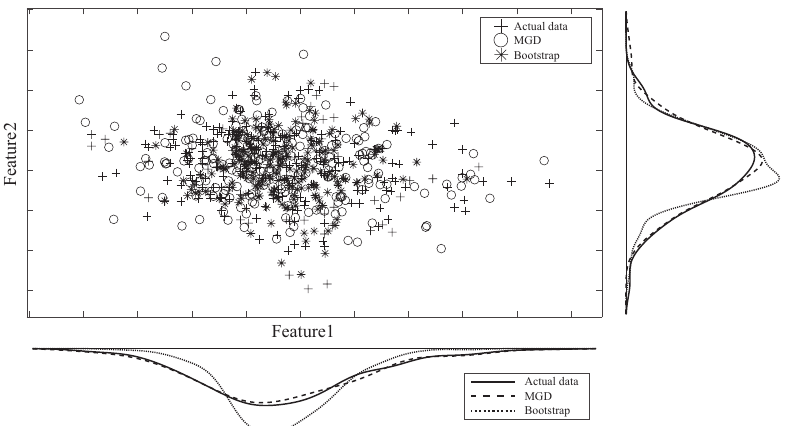
Figure 7. Delineation for strength of the